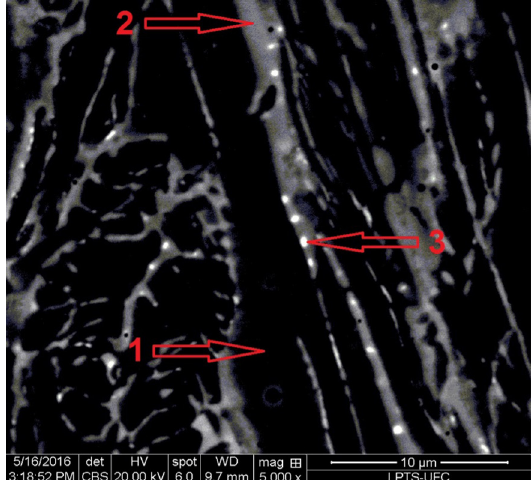
Figure 7. Microstructure of the zone fused with the AWS ER2209 electrode using energy of 8 kJ / cm with 50 hours of TTE. Highlight for phases (1)